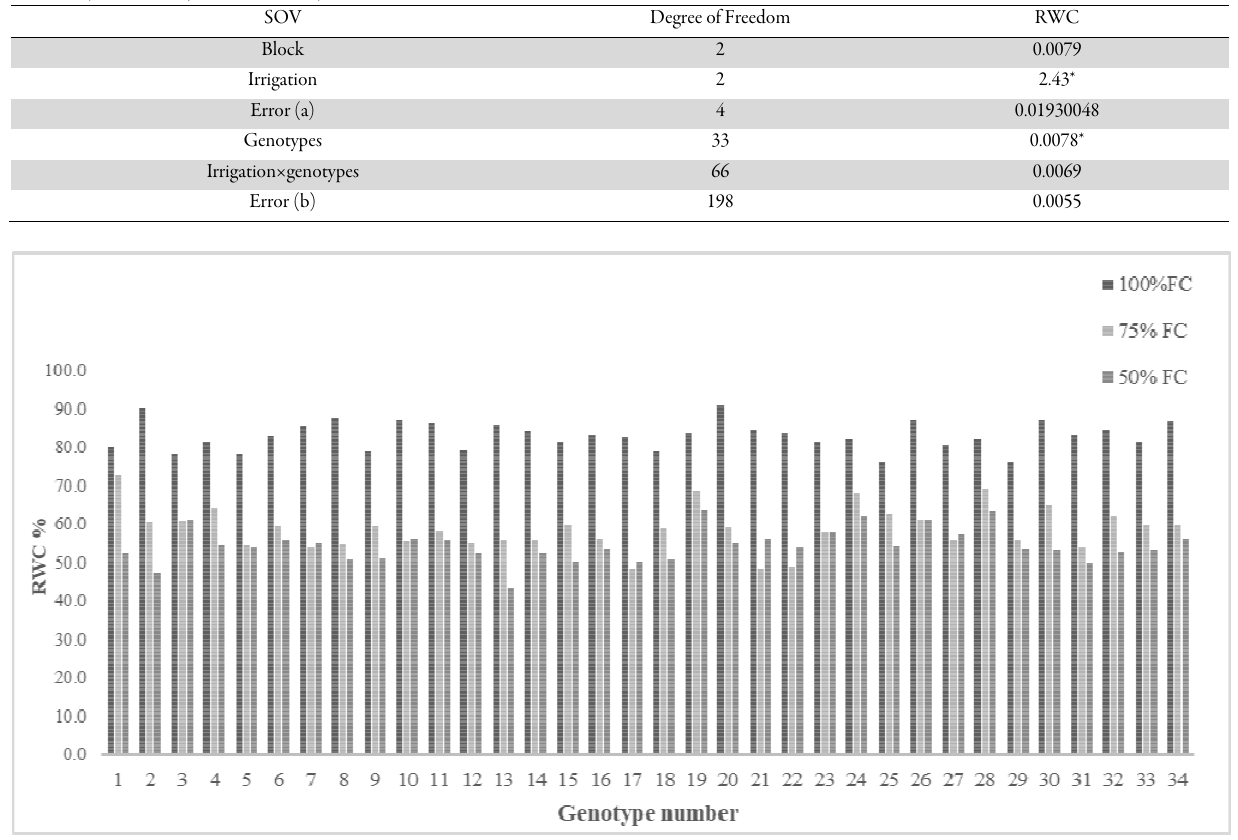
Fig. 1. Relative water content (RWC) in thirty-four hexaploid wheat genotypes under normal and stress irrigation (75 and 50 % field capacity) conditions. (LSD = 5%